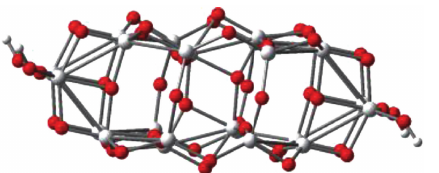
Figure 4: Lateral view of the optimized structures of the Ti 24 O 50 H 4 nanoclustermodelingtheanatasetitania(101)surface.Thegeometry optimization was performed at DFT/B3LYP/3-21G(d)